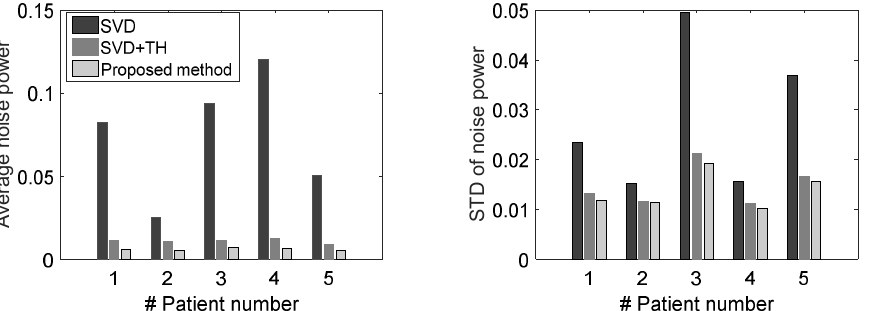
Figure 7. Mean and standard deviation of noise power for the microvasculature images of five breast lesions, comparing SDV, SVD+TH, and the proposed method (NLM+TH).